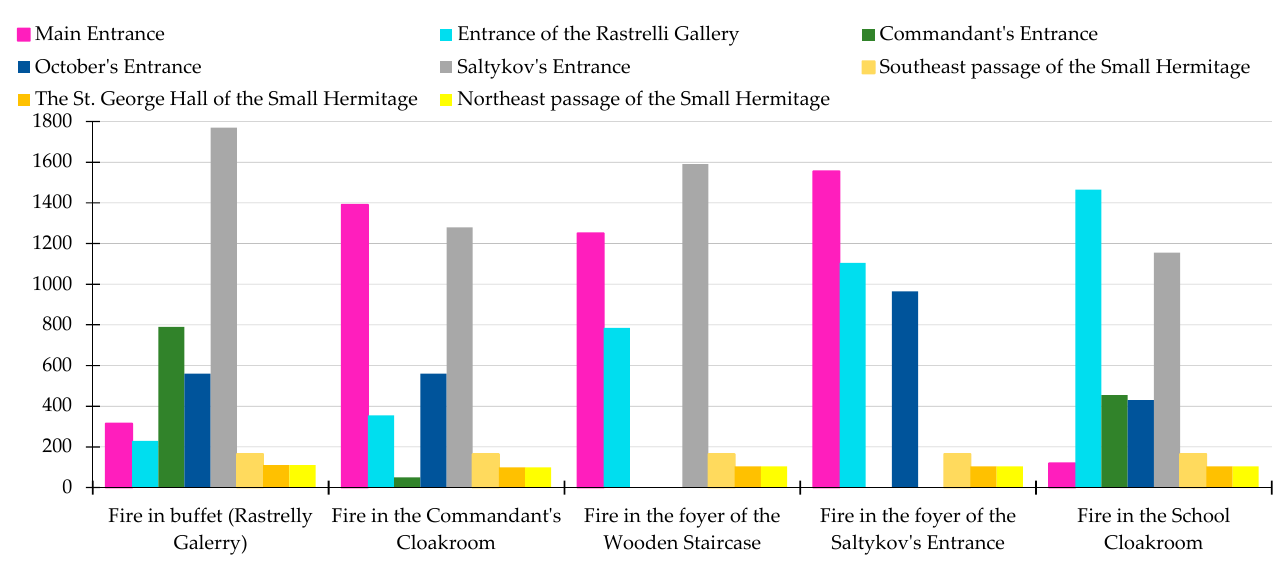
Figure 20. Distribution of people to the exits of the building.